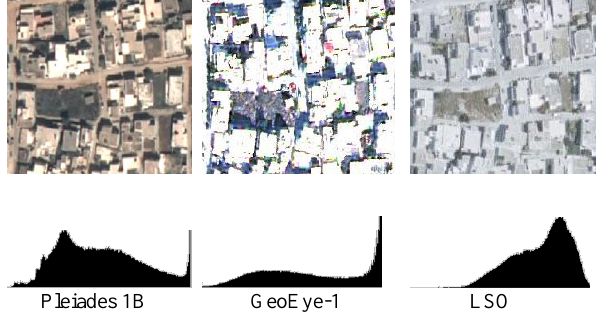
Figure 5. Examples of visual errors/defects of the orthoimages and their corresponding histograms